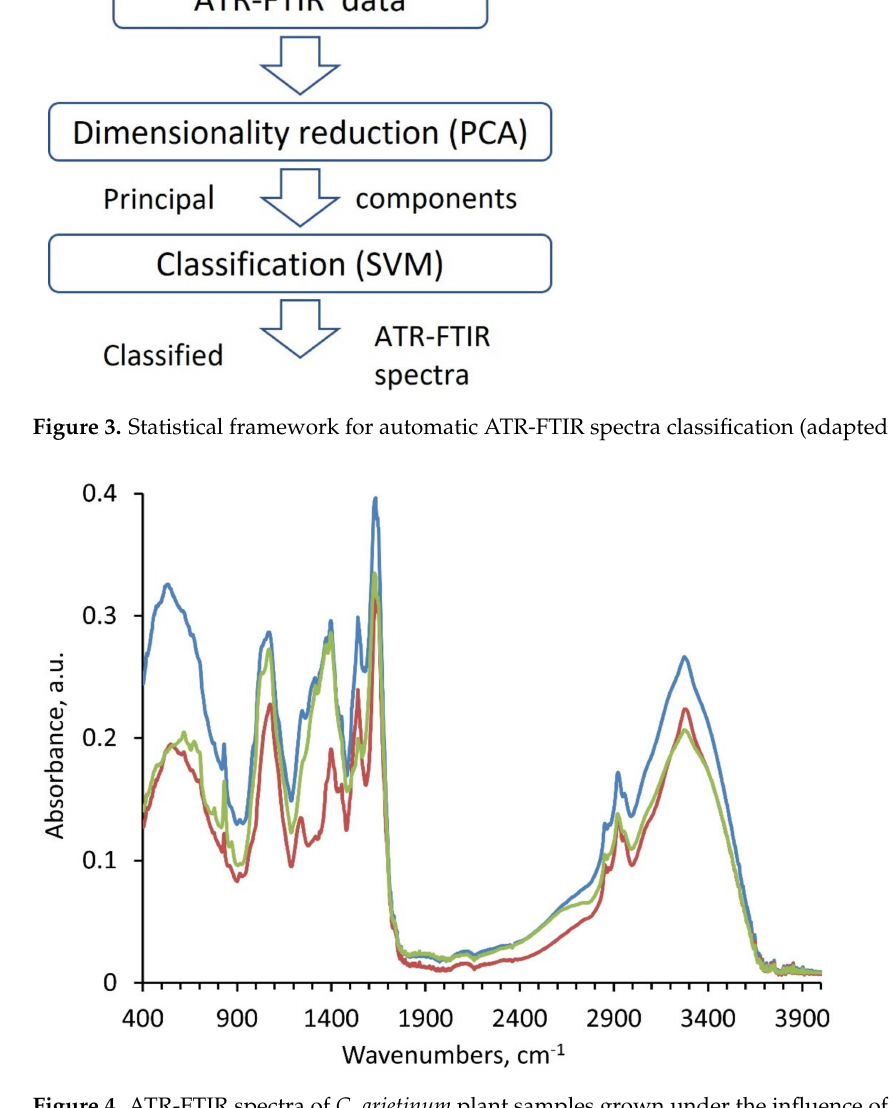
Figure 4. ATR-FTIR spectra of C. arietinum plant samples grown under the influence of Au NPs and CNTs. Note: Control—red line, Au NPs-treated plant—blue line, and CNTs-treated plants—green line. The ATR-FTIR clearly identified three tested